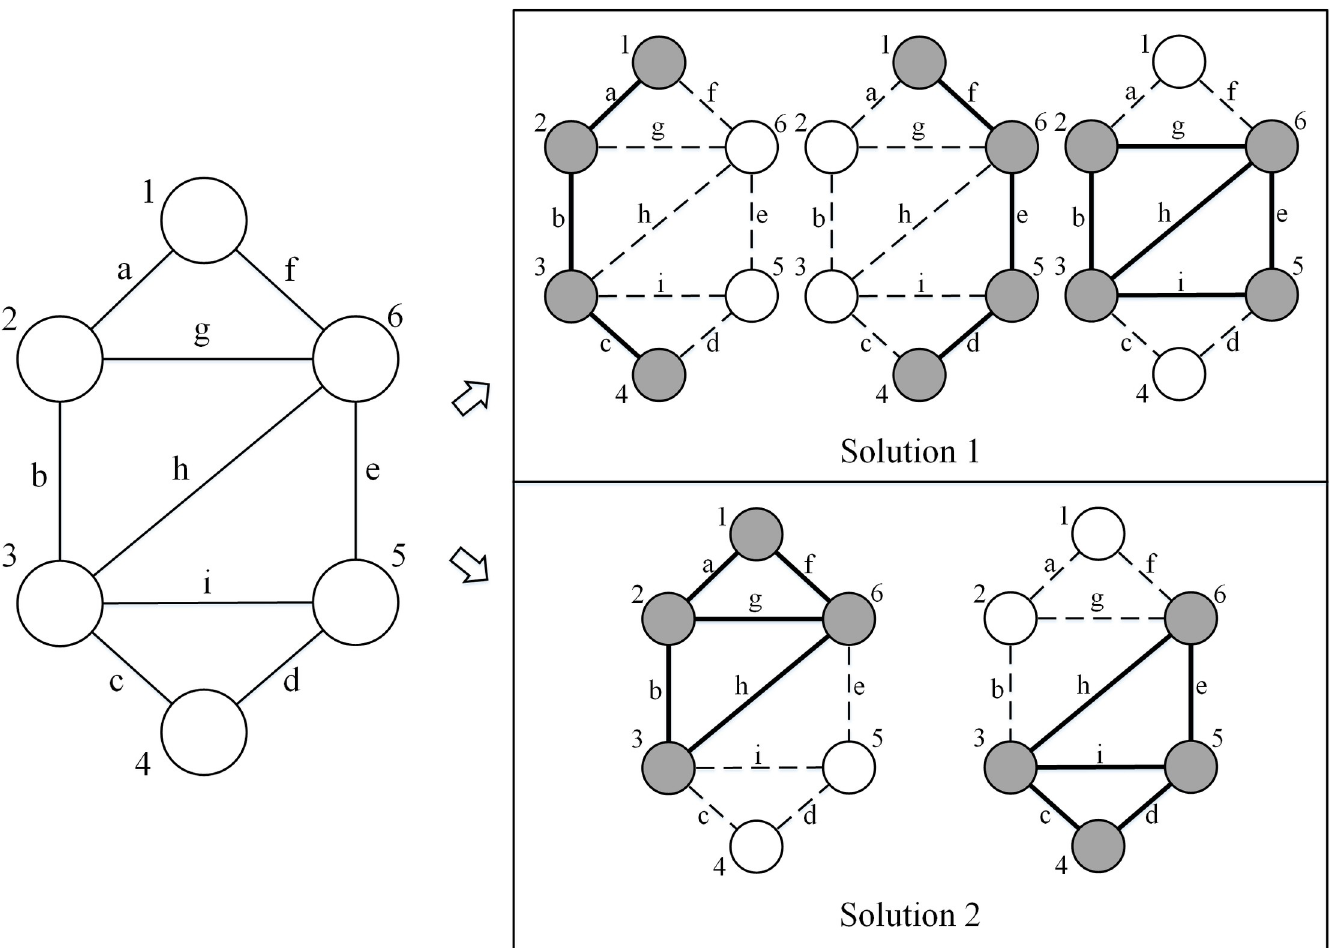
Fig 2. An illustration of the optimization problem of finding multiple subgraphs that best cover the input networks. The left part is the input network which consists of six nodes and nine edges. The right part contains the solutions by extracting multiple subgraphs. Solution 1 requires three subgraphs and solution 2 requires two subgraphs. In the solution part, grey nodes represent the included nodes and white nodes represent the omitted nodes. Dashed lines represent unobserved ties, while bold solid lines represent the extracted ties.